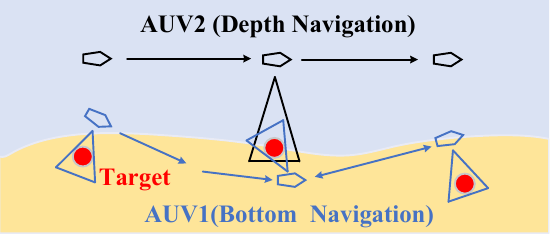
Figure 1. 2D exemplification of AUV simulation trajectory planning.